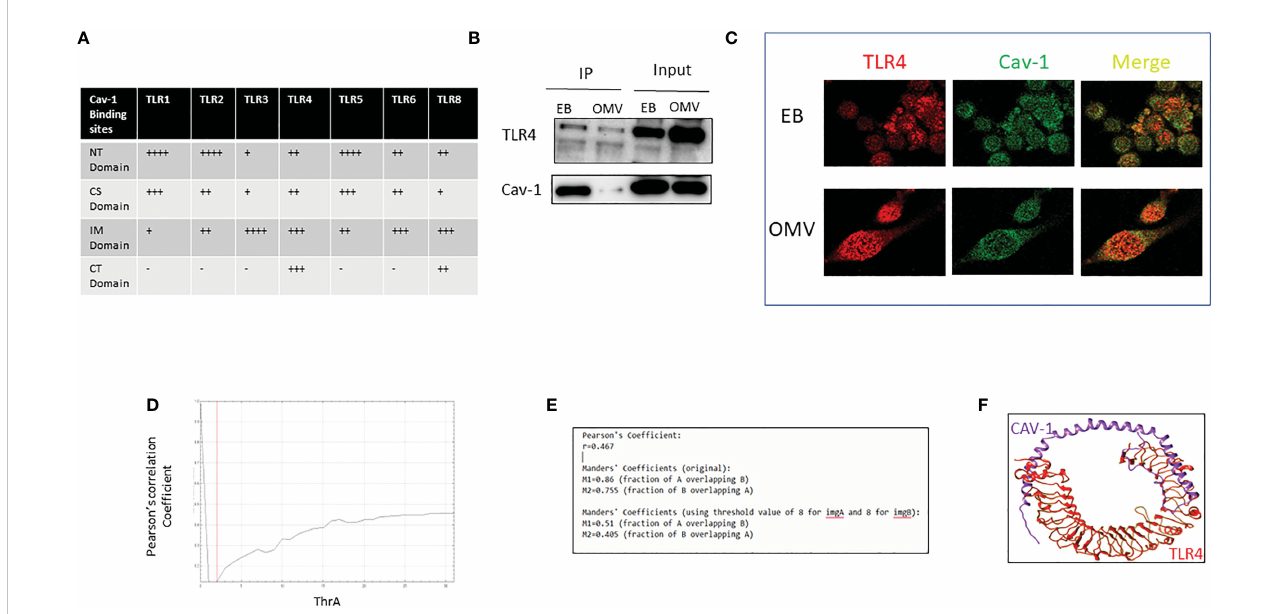
FIGURE 4 Analysis of the interaction of Cav-1 and TLR4. The table indicates the binding sites of Cav-1 in various TLRs (A) . WT AM was treated with 0.1g/ml of OMV for 3h; cell lysate was collected, Cav-1 immunoprecipitated, and TLR4 was detected by the immunoblotting method. 15% of cell lysate was used as input (B) . Confocal microscopic images of colocalized TLRs (red) and cav-1 (green) after EB/OMV treatments (magni fi cation = ×63) (C) . Graphical representation of values of Pearson's coef fi cients (D) , Colocalization coef fi cient values using confocal images of TLRs (red) and cav-1 (green) after EB/ OMV treatment (E) . 3-D image shows the interaction of Cav-1 in the active sites of TLR4 (F) . + indicates the binding sites cav-1, - indicates no binding sites of